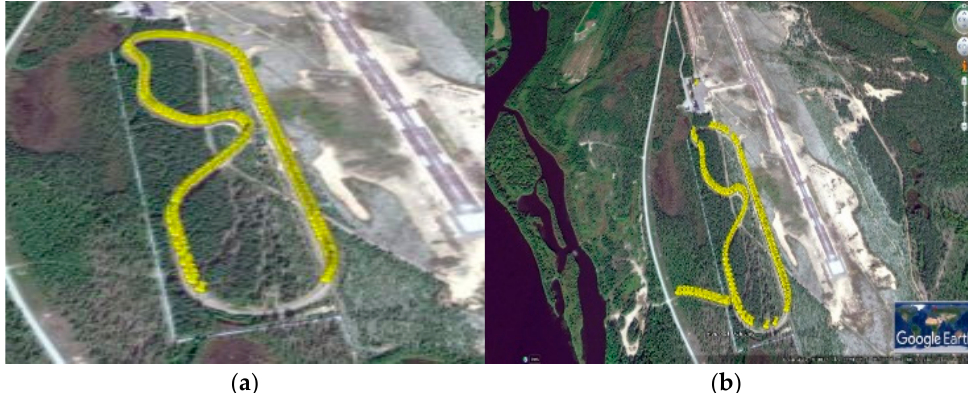
Figure 8. ( a ) Packet capture using 5GTN ( b ) Packet capture using heterogeneous (5GTN and ITS-G5) network.